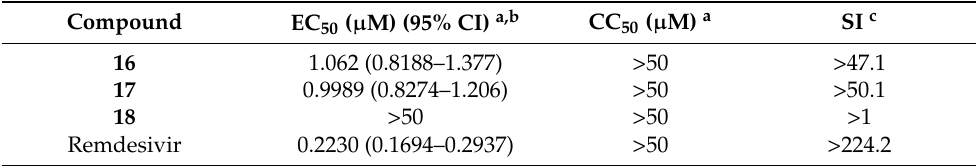
Table 3. Anti-FIPV activity and cytotoxicity of the tested compounds in CRFK cells.